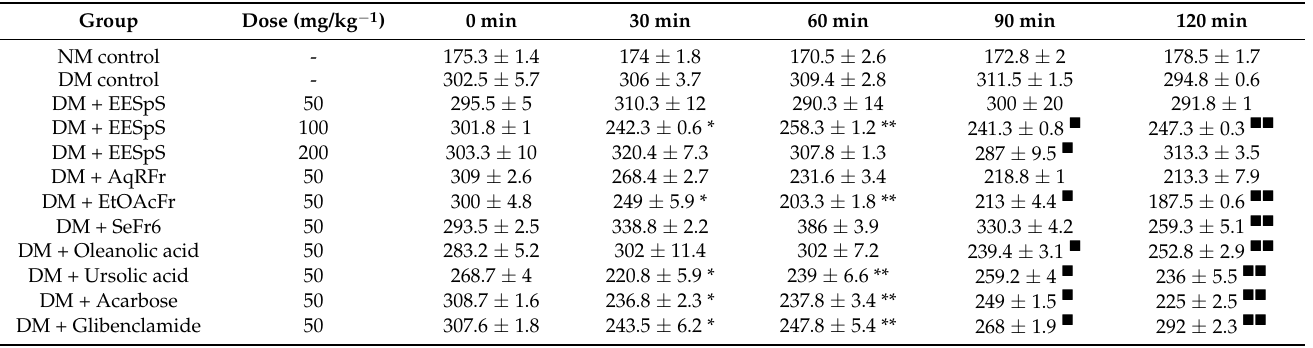
Table 2. Acute effect of the ethanolic extract of stems from S. polystachya and its products over